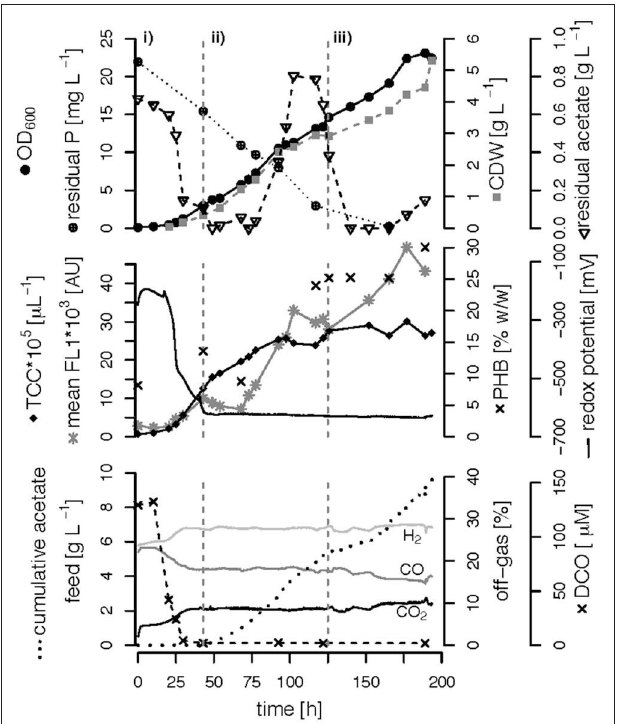
FIGURE 5 | C,P-limited fed-batch fermentation. R. rubrum was grown on modified RRNCO medium with yeast extract as sole P source and a continuous supply of syngas. The three different growth phases of the process are separated by gray dashed lines: (i) batch phase during which the initial acetate is consumed, (ii) acetate fed-batch, (iii) acetate fed-batch C and P limitation. All abbreviations are the same as in Figure 3 .